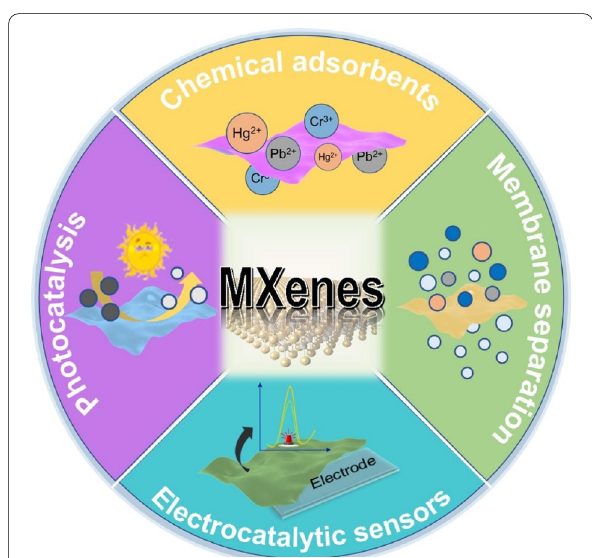
Fig. 1 Schematic illustrating the use of MXenes in environmental remediation technologies such as adsorption, membrane separation, photocatalysis, and electrocatalytic